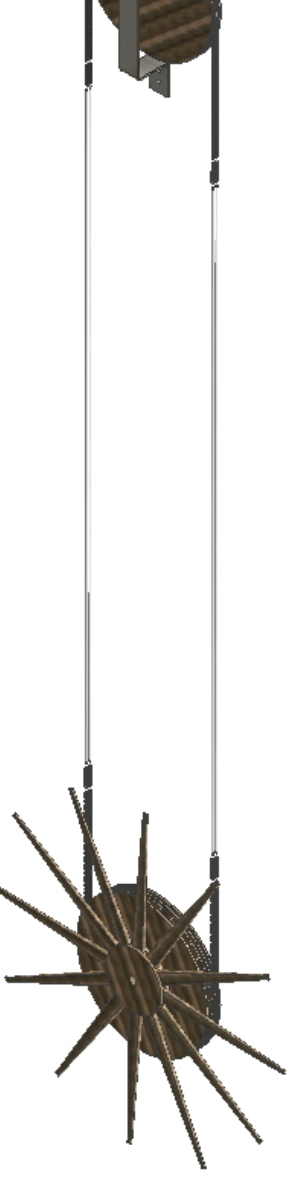
Figure 13. Detail of the transmission between the upper wheel and the winch.